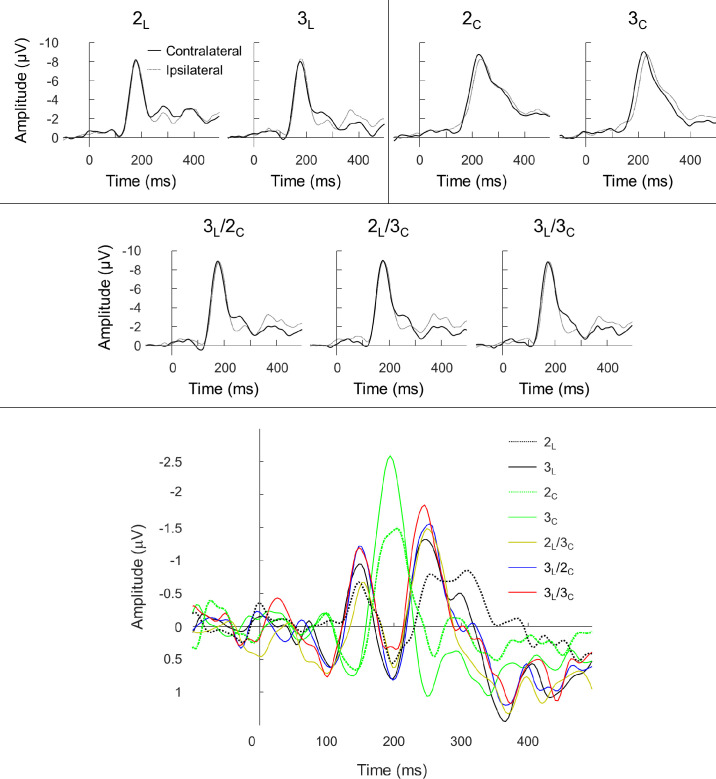
Grand-average contralateral and ipsilateral waveforms (to the target location) at the PO7/8 electrodes (top) and grand-average difference waveforms (bottom) for the seven conditions of Experiment 2. Note that negativity is plotted upwards. For the contralateral/ipsilateral graphs, the single-feature conditions are on the top and the three combination conditions are on the bottom. Note the faster latencies and steeper slopes of the posterior negativity in luminance and combination conditions compared to chromatic conditions. For the difference waveforms, note the distinct difference waveform pattern for luminance and combination conditions compared to the chromatic conditions.